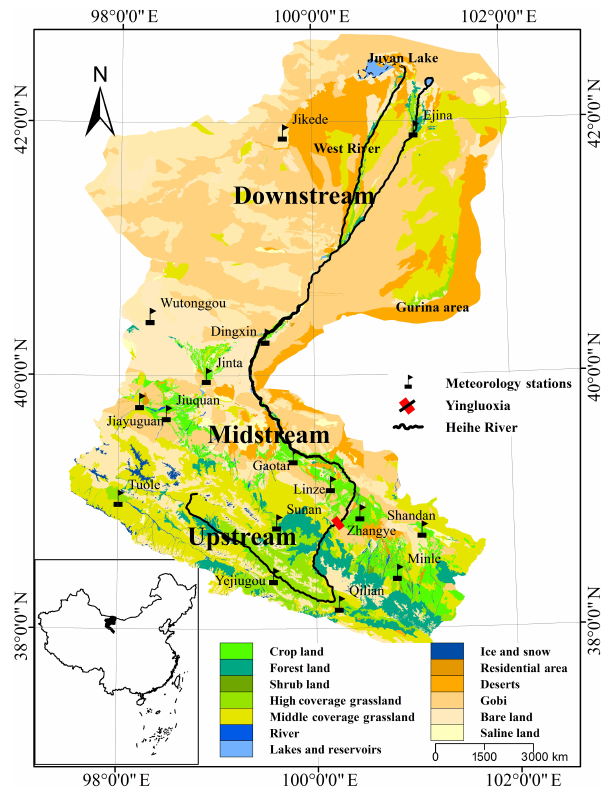
Figure 1. Location of the Heihe River basin (HRB). Land cover data (2011) are available at the WestDC database (http://westdc.